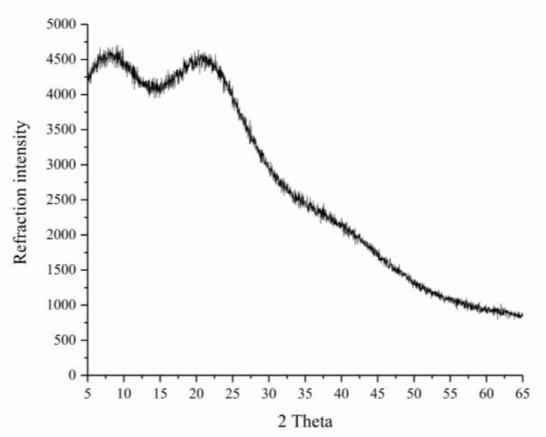
Figure 4. X-ray di ff raction pattern of